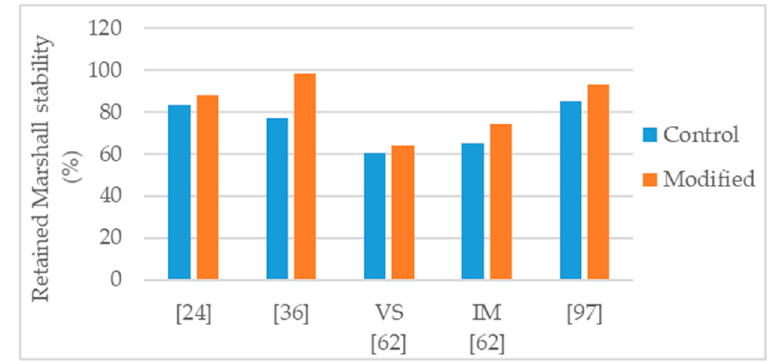
Figure 4. Retained Marshall stability of control and nanosilica modified asphalt mixtures.